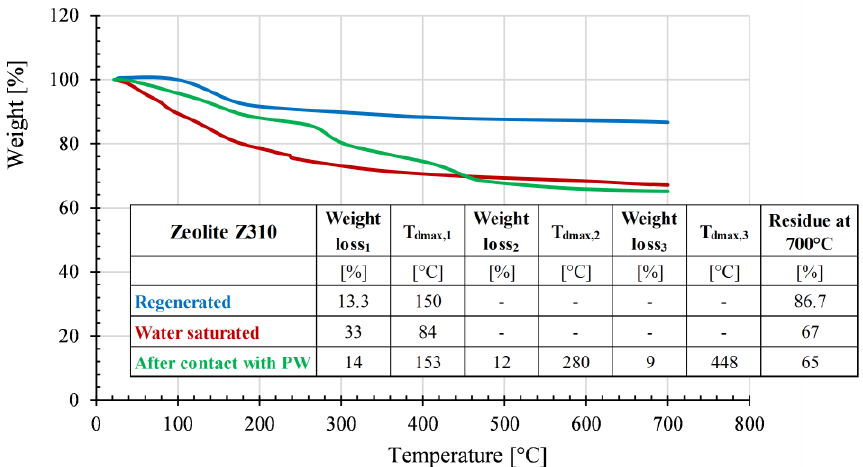
Figure 7. Results of the preliminary panel tests on ( a ) PW- and ( b ) Fil-S-based composite with the zeolites.